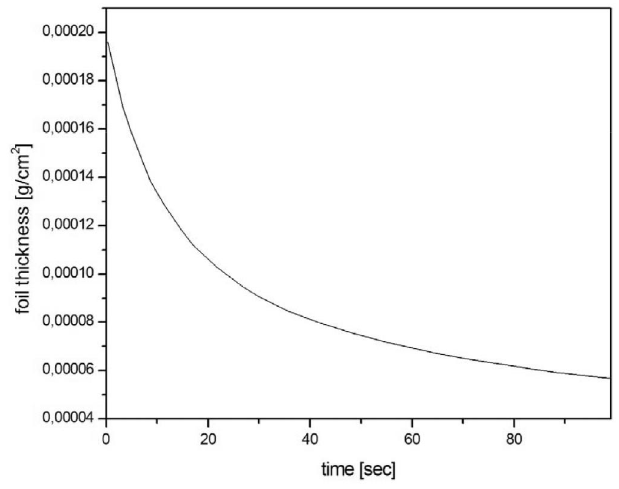
FIG. 2. Nonlinear foil thickness decreasing caused by the reduction of temperature at the BNL linac pulse current of 3